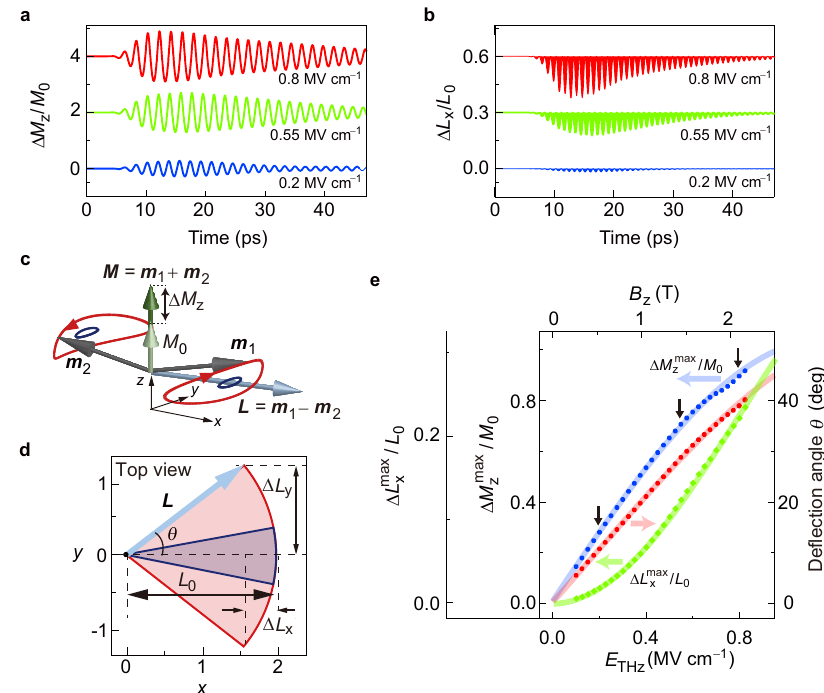
Fig.3|Analysisofmagnetizationchanges Δ M z / M 0 and Δ L x / L 0 basedontheLLG equation. a , b Calculated dynamics of Δ M z / M 0 ( a ) and Δ L x / L 0 ( b ) for E THz =0.8, 0.55, and 0.2MVcm − 1 . The red and green curves are offset for clarity. c The de fi - nitions of the ferromagnetic vector M (green arrow) and the antiferromagnetic vector L (blue arrow) are shown. The red and blue curves describe the precession motionof the sublatticemagnetization( m 1 and m 2 ;grayarrows) for E THz =0.8 and 0.2MVcm − 1 , respectively. Because the z -axis component of the actual trajectory is much smaller than the components in the x – y plane ( ∣ M z ∣ ≪ ∣ 4 L x ∣ , ∣ 4 L y ∣ ), the tra- jectoriesaremagni fi edalongthe z -axisforclarity. d Topviewof( c ).Thegrayarrows